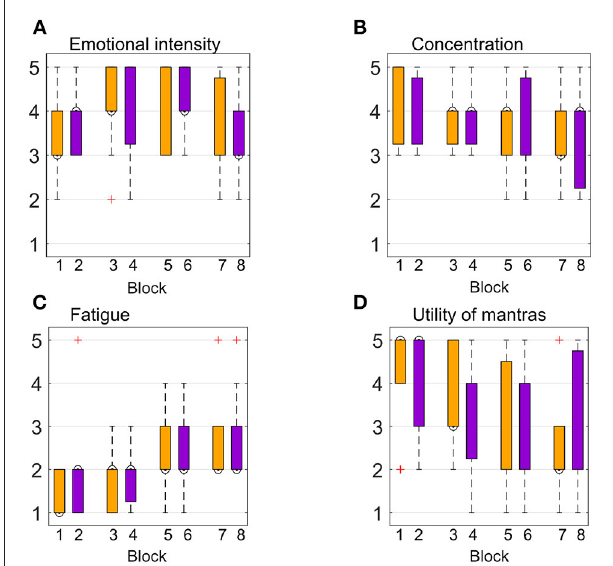
FIGURE 8 | Participants’ subjective ratings were assessed at the end of each of the eight blocks (four for each emotion). Orange refers to the “tenderness” condition, while purple refers to “anguish.” The y-axis represents the 5-point Likert scale, going from “very mild” to “very intense” for (A) , from “very low” up to “very high” for (B,C) , and from “not useful” to “very useful” for (D)